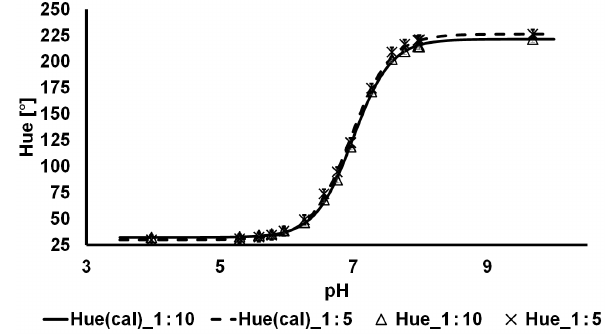
Figure 10. Hue data (mean value of 10 measurements) depend- ing on pH values measured in the same chamber. BTB diluted in ratios of 1:10 and 1:5 in SPPB. Fitting parameters are the following: pK a (1:10) = 6.99, α (1:10) = 1.53, 2 σ (1:10) = 2.97 ◦